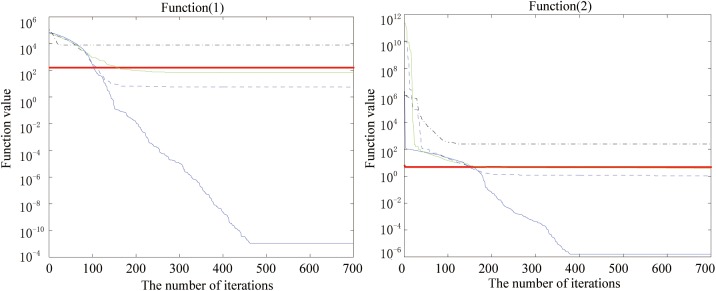
The fitness value of various algorithms for Sphere and Schwefel’s problem 2.22 during increasing iterative times.